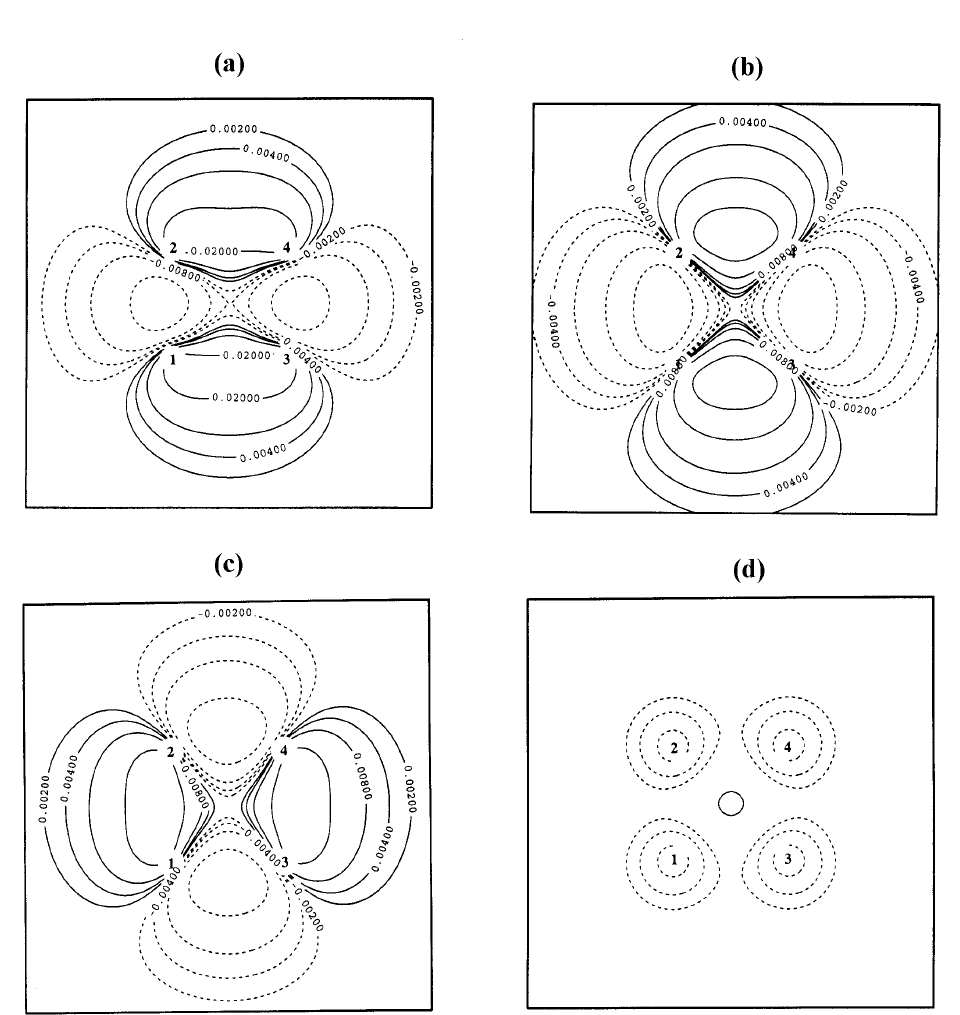
Figure 3: Contour line diagram of the difference electron density distribution ∆ ρ ( r ) = ρ (method I) - ρ (method II) of the reaction complex H 2 + H 2 calculated with the cc-pVTZ basis at a geometry close to the transition state (R(H1-H2) = 1.212; R(H2-H4) = 1.244 ˚A). Solid (dashed) contour lines are in regions of positive (negative) difference densities. Reference plane is the plane containing the four nuclei. The positions of the atoms are indicated by numbers 1 to 4. The contour line levels have to be multiplied by the scaling factor 0.01 and are given in e bohr − 3 . a) Method I: BS-UHF; method II: RHF. b) Method I: RLDA; method II: RHF. c) Method I: BS-ULDA; method II: RLDA. d) Method I: BS-ULDA; method II: BS-UHF. The LDA calculations were carried out with the Slater exchange-only